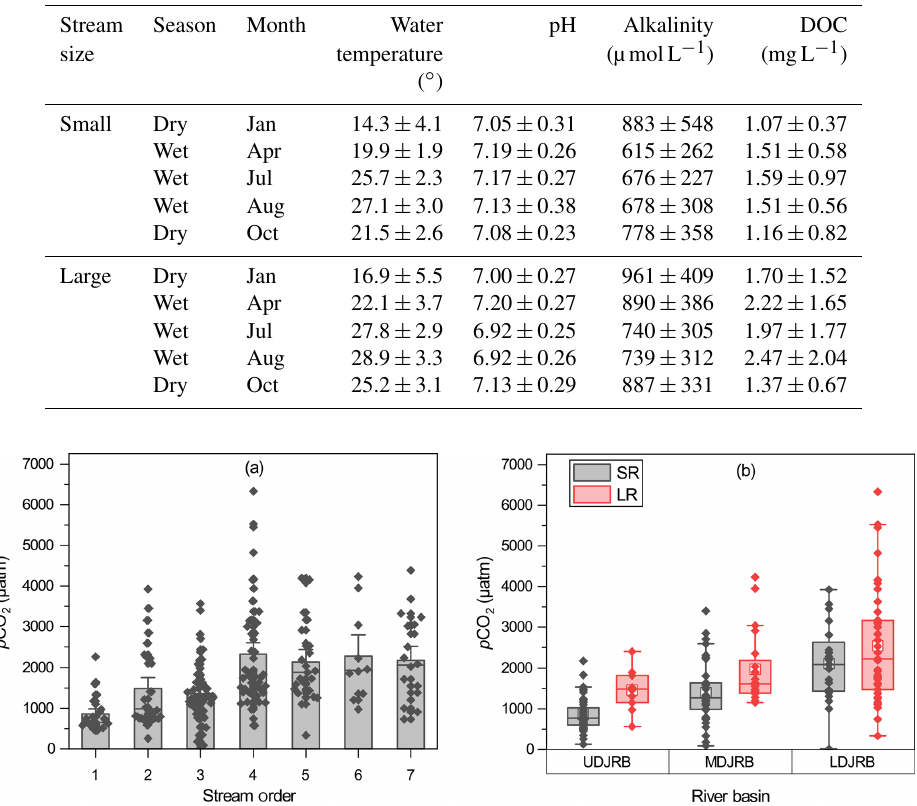
Table 1. Seasonal variations in physical and biochemical characteristics, expressed as mean ± SD.